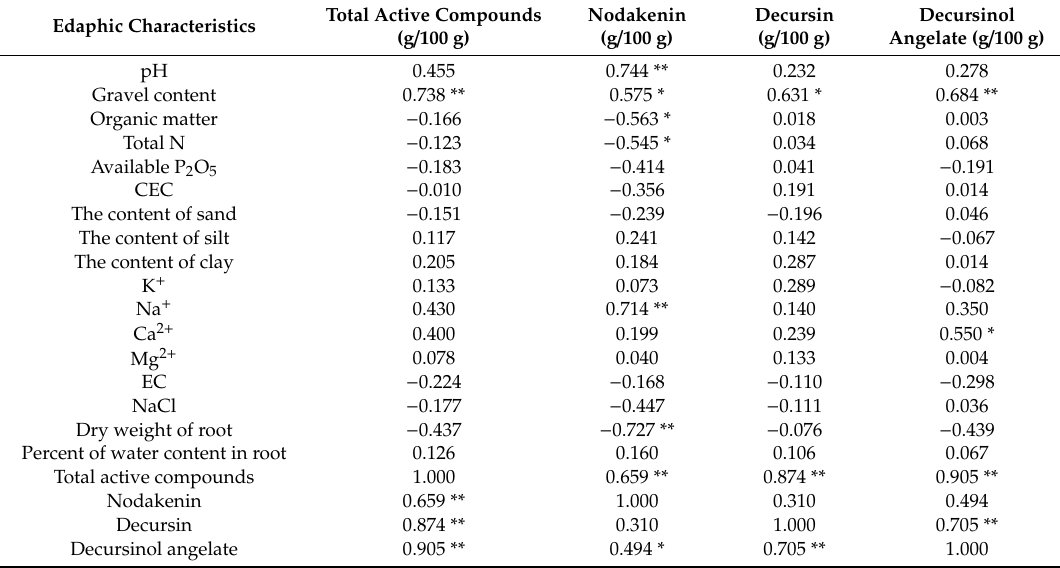
Table 8. Correlation coe ffi cients between active compounds and edaphic characteristics in Angelica gigas Nakai cultivation sites,